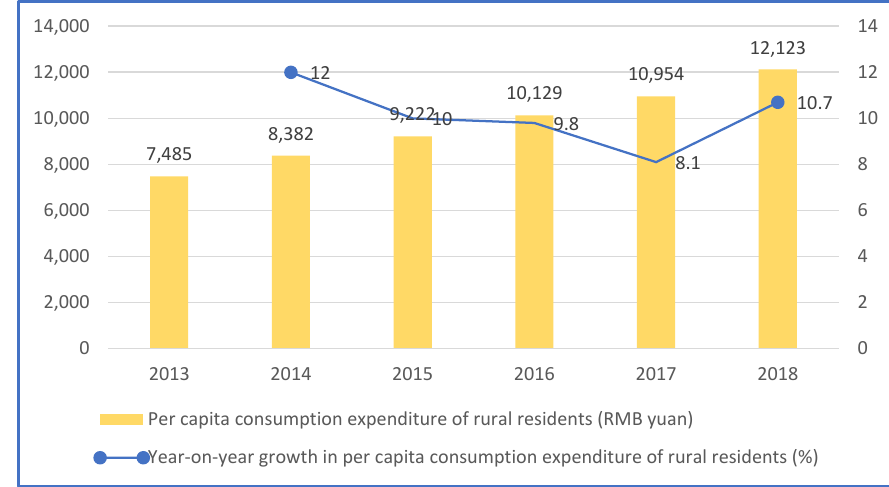
Figure 1. Trend of per capita consumption expenditure of rural residents in China 4 .